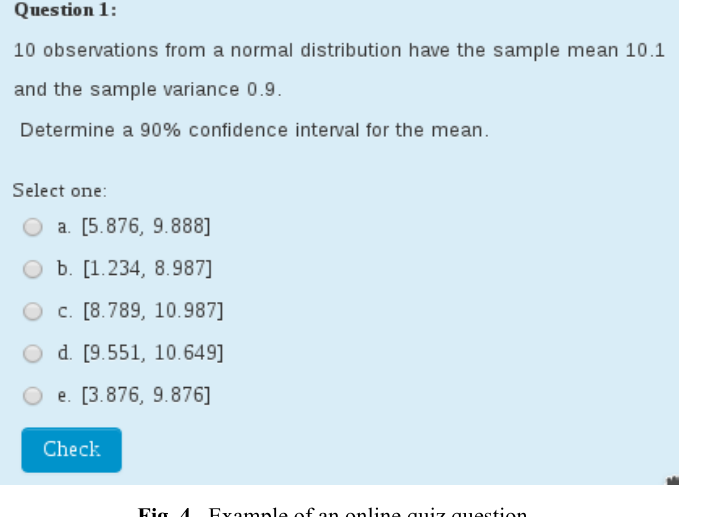
Fig. 4. Example of an online quiz question.